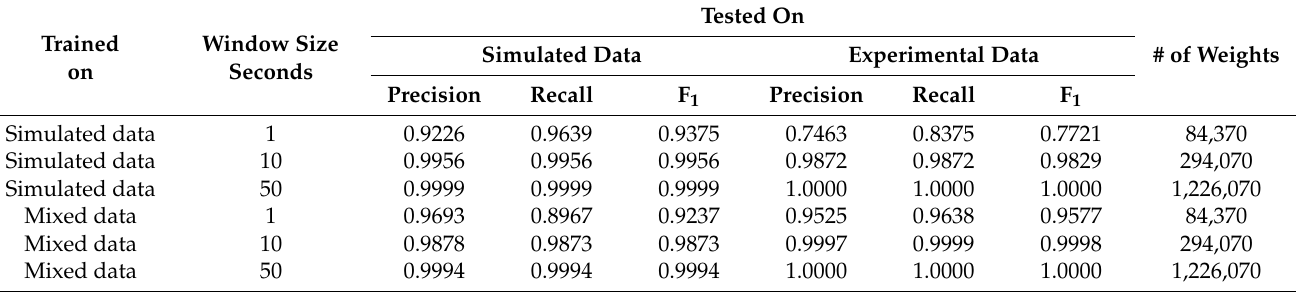
Using only simulated data the model showed larger reconstruction error, and lower precision and recall. Training the model on a mixed dataset with 0.2% of experiment samples resulted in a better performance than when we used only the simulated data, as expected. The exact percentage of the experimental data was chosen by starting with 0.1% and increasing with 0.1% steps while measuring the impact. At 0.1% with a 1-s GCAEC model we observed 3% lower F 1 values on average than at 0.2%. Training a 1-s GCAEC model on 0.3% of the experimental data in the training dataset improved the metric by less than 0.001% compared to a 0.2% mix, at which point we decided that we reached optimal results at 0.2%. The detailed analysis of how the quality changes as a function of the training dataset mix would be an interesting question to explore in the future. We can conclude that a 10-s window is a good compromise between the performance and the model size. A window size also correlates with the class separation which can be seen in Figure 8. Using a window longer than 1 s made the fault degradation states to be distinguishable by the parameters in the embedding